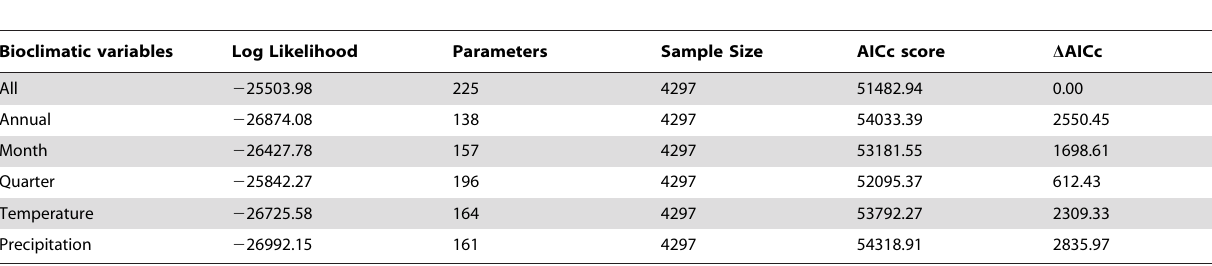
Table 2. Akaike Information Criterion, with finite sample size correction (AICc), for distribution models of limber pine trained at the local extent using six different combinations of bioclimatic variables.